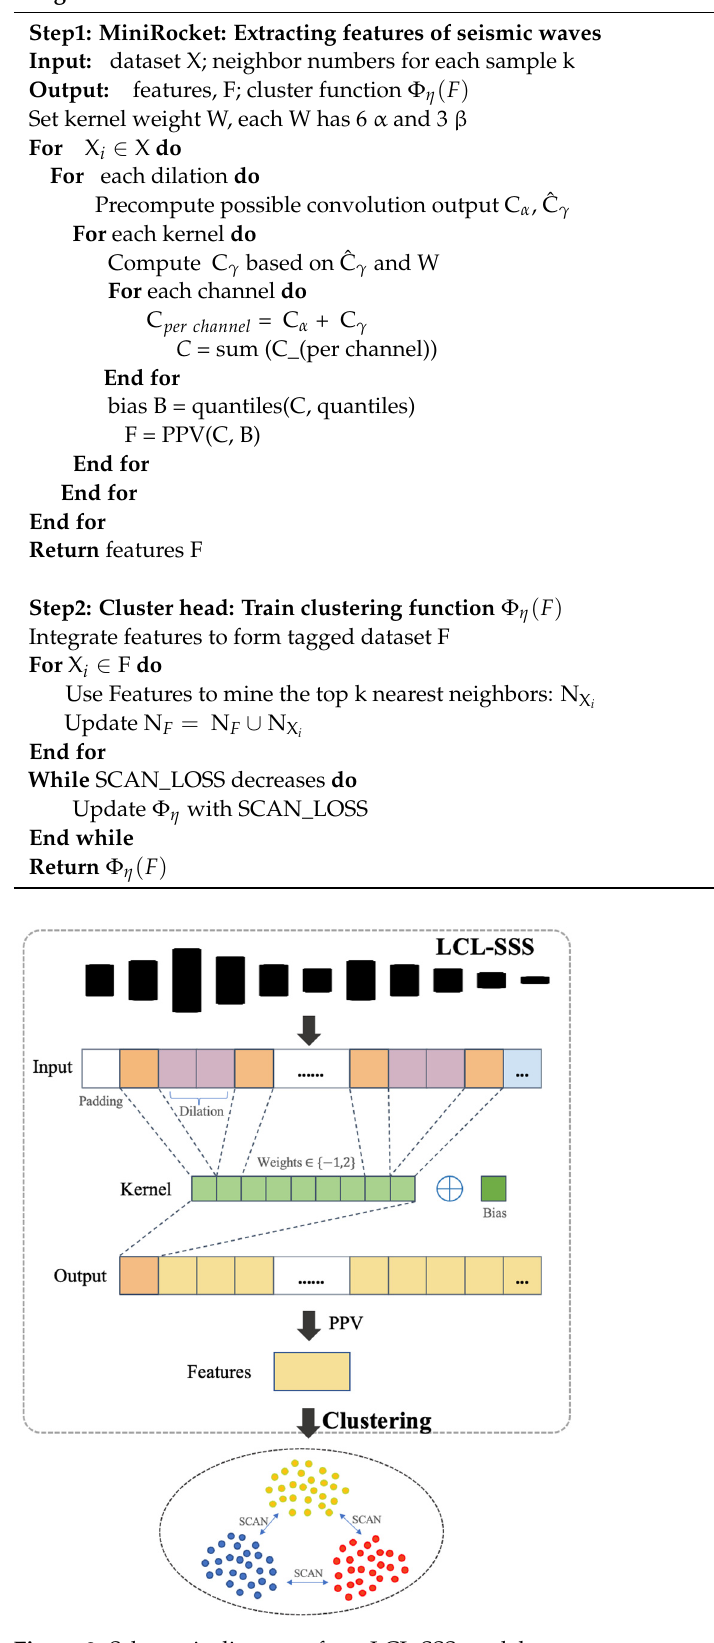
Algorithm 1: MiniRocket + Cluster head.